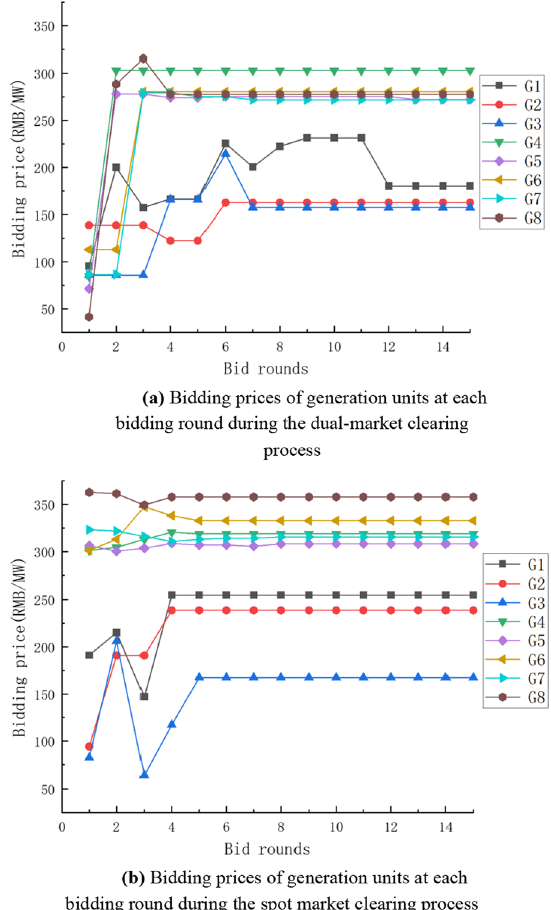
Fig. 8 a Bidding prices of generation units at each bidding round during the dual-market clearing process. b Bidding prices of generation units at each bidding round during the spot market clearing process